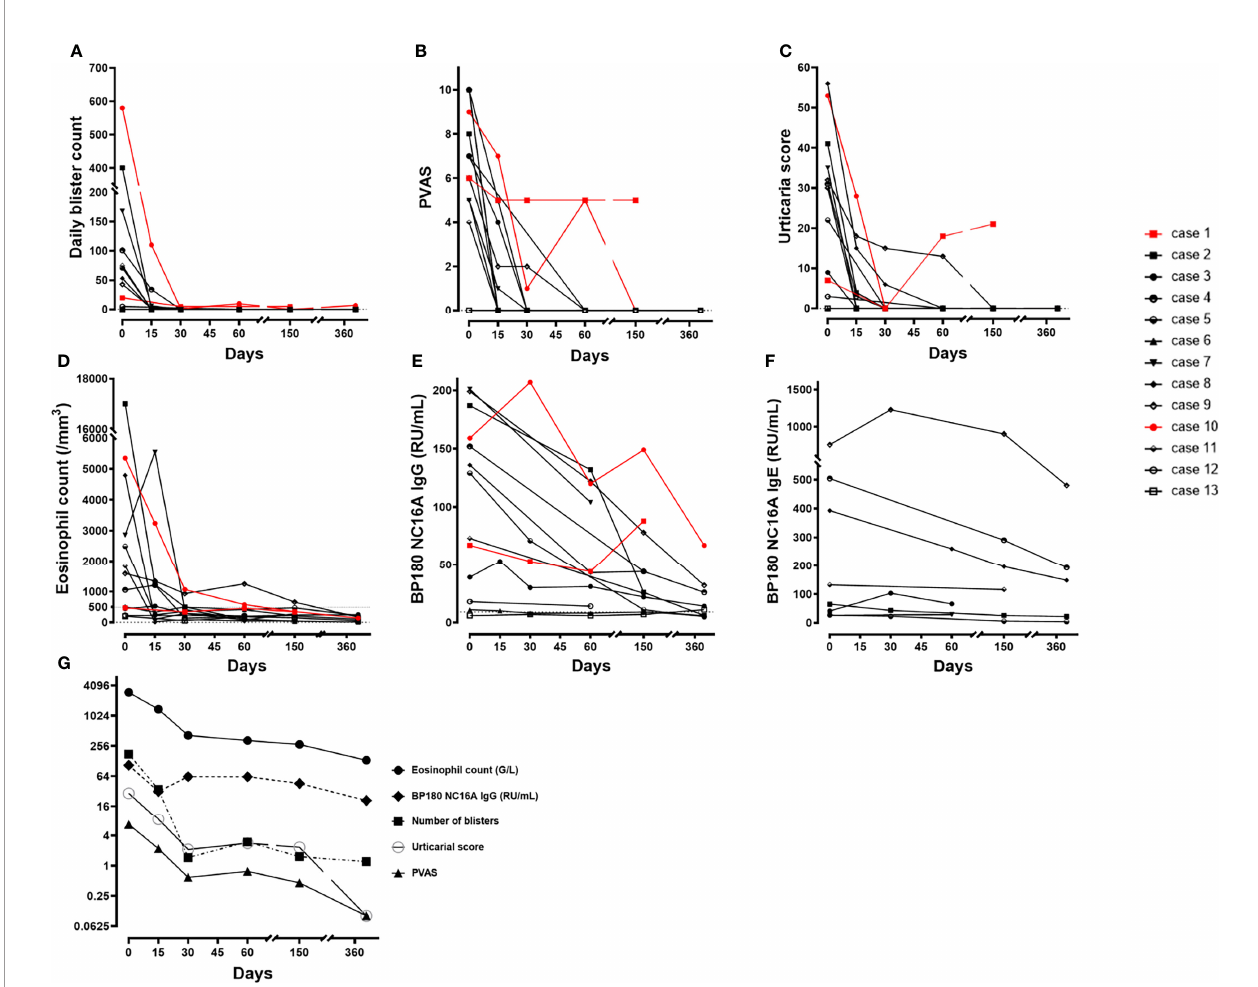
FIGURE 4 | Clinical and laboratory variables during the fi rst year after omalizumab therapy in the 13 patients. Individual values through time on a linear scale (black: remittent patients, red: non – remittent patients): (A) Daily blister count, (B) Pruritus visual analogic score, (C) Urticaria score, (D) Eosinophil count, (E) BP180 – NC16A IgG level, (F) BP180 – NC16A IgE level over time for the 8 patients with measurable IgE auto – antibodies during follow – up, (G) Log – 2 scale evolution of the mean values over time of eosinophil blood count, daily blister count, pruritus visual analogic score, and BP180 – NC16A